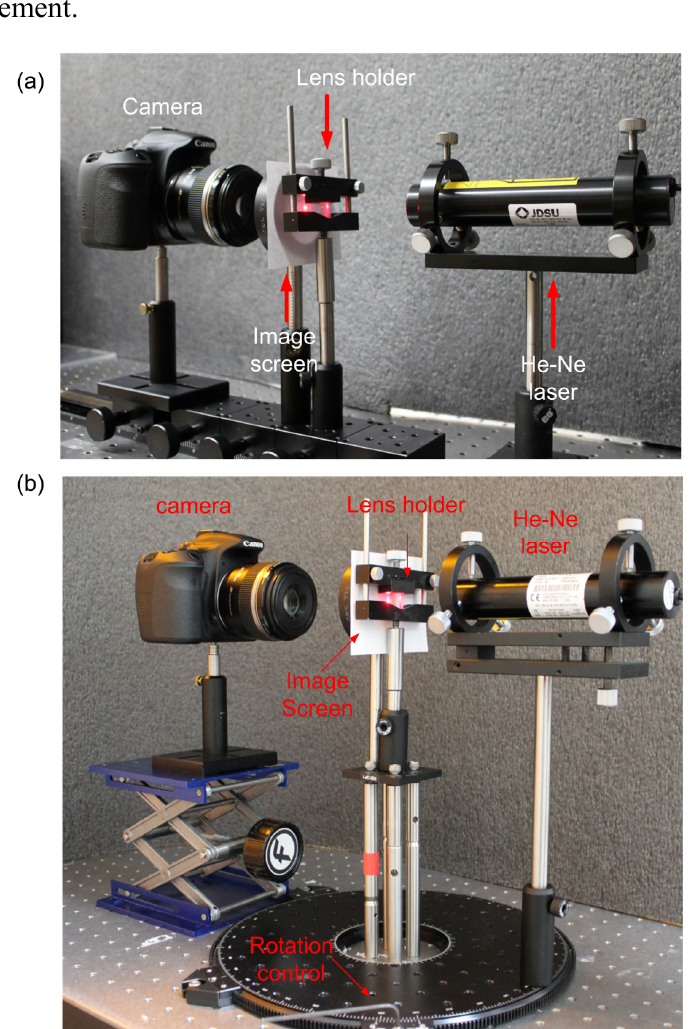
Figure 5. Photograph of the optical setup used for ( a ) image acquisition and ( b ) FOV